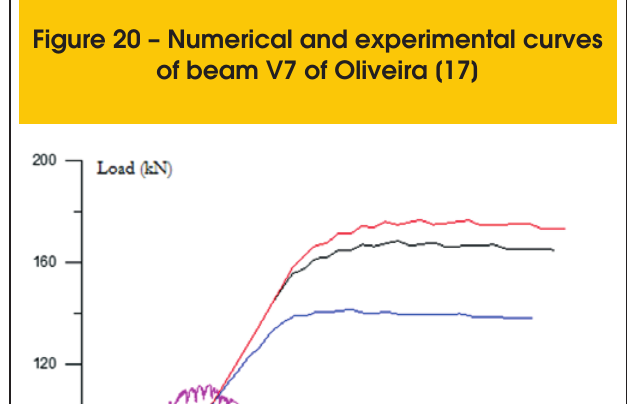
Figure 21 – Damage by tensile (D) in beam V7 of Oliveira [17]